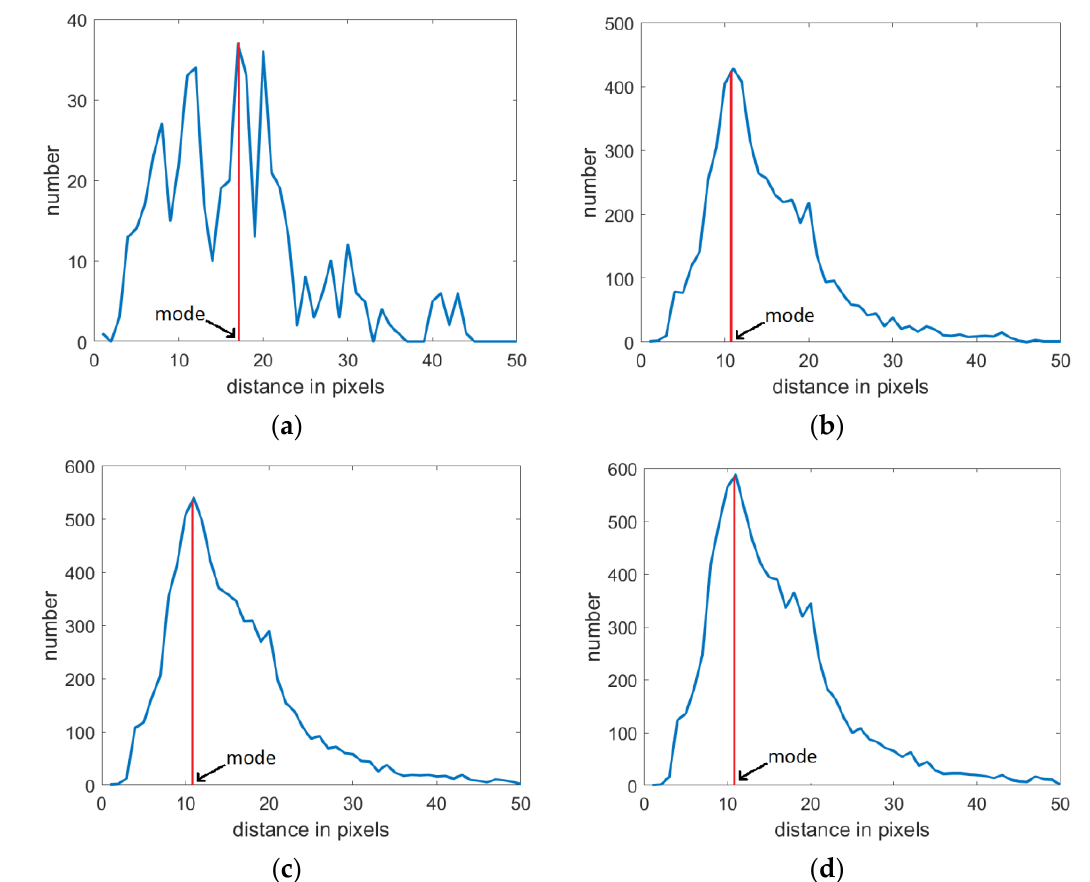
Figure 7. Histograms of distribution of distance d i , i = 1 . . . N p between the lines corresponding to the striations (in pixels), detected in fragments 1–4 ( a – d ), highlighted in the fractographic image in Figure 1.